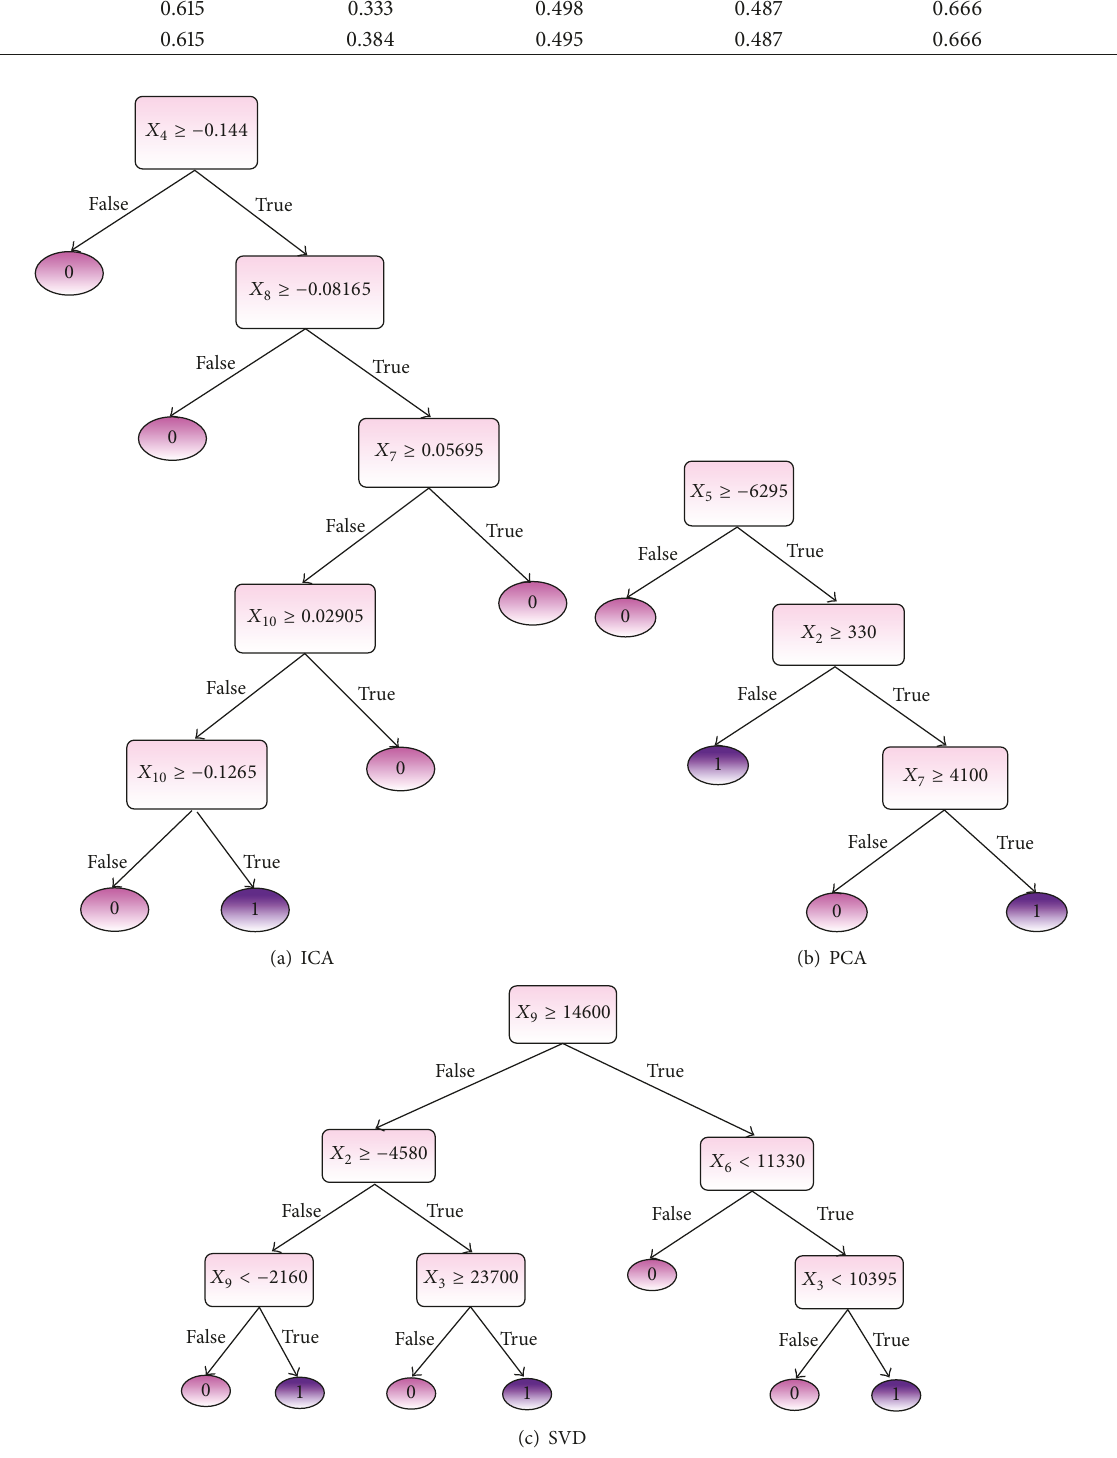
Figure 6: Illustration of tree evolution for the CART for ICA, PCA, and SVD data reduction